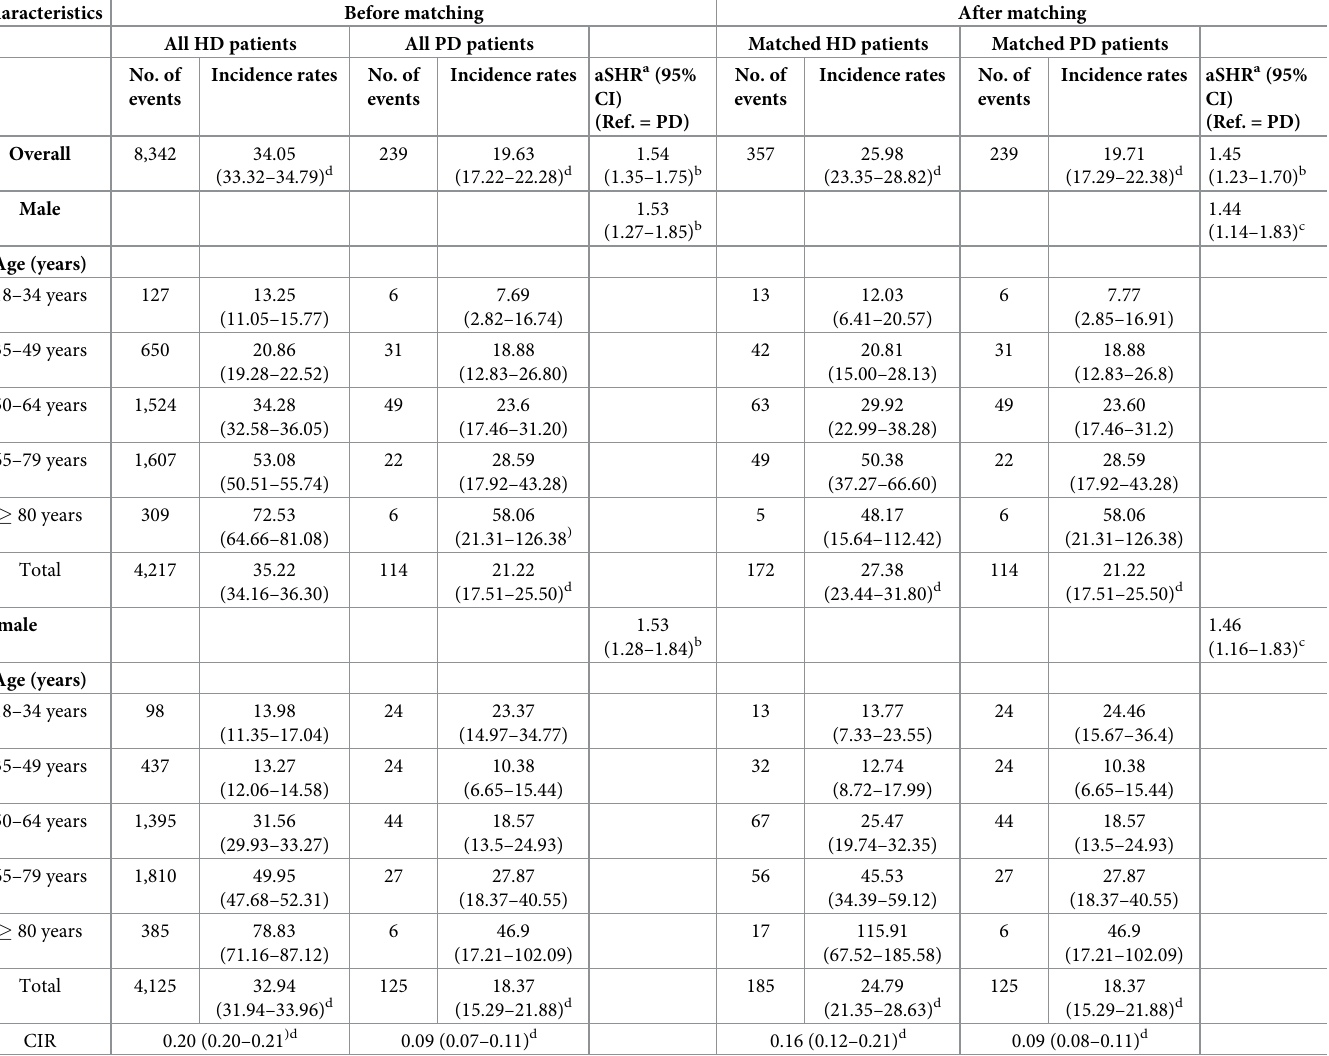
Table 2. Comparison of incidence rates (per 1,000 patient-years) and subdistribution hazard ratios of congestive heart failure between patients with hemodialysis (HD) and peritoneal dialysis (PD) before and after matching for propensity score.